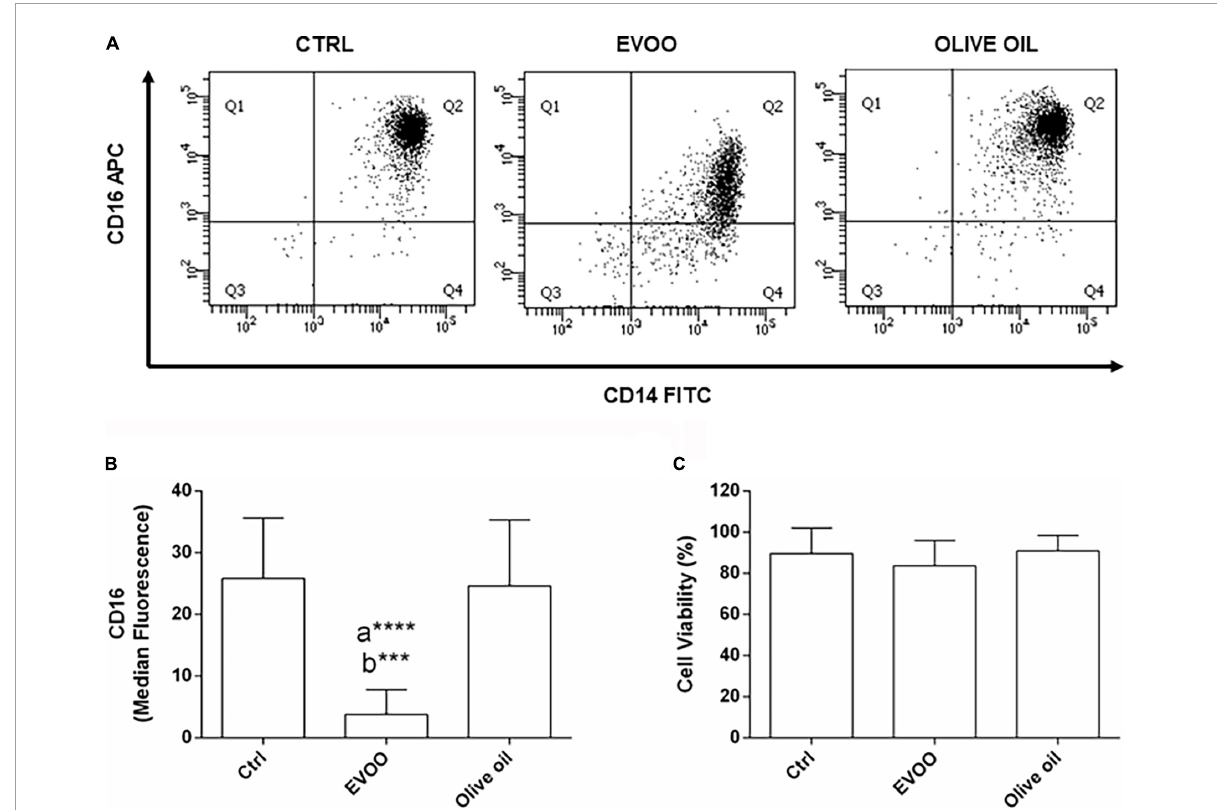
FIGURE1 EVOO extract significantly reduced the expression of CD16 molecule among the pro-inflammatory CD14 + CD16 + monocyte population in PBMCs from obese children. (A) Representative dot plot of CD14 and CD16 expression on monocytes (CD64 + CD45 + ) from PBMCs, each treated for 24 h with Ctrl, EVOO, and olive oil extracts (6.25 µ g/mL each). (B) Histogram represents CD16 cell surface expression calculated on CD14 + CD16 + cell population. Data are expressed as a mean of median fluorescence ± SEM ( n = 13). (C) Histogram indicates the percentage of cell viability ± SEM ( n = 13) in the experimental groups. a: EVOO vs. Ctrl; b: EVOO vs. olive oil **** p < 0.0001, *** p <